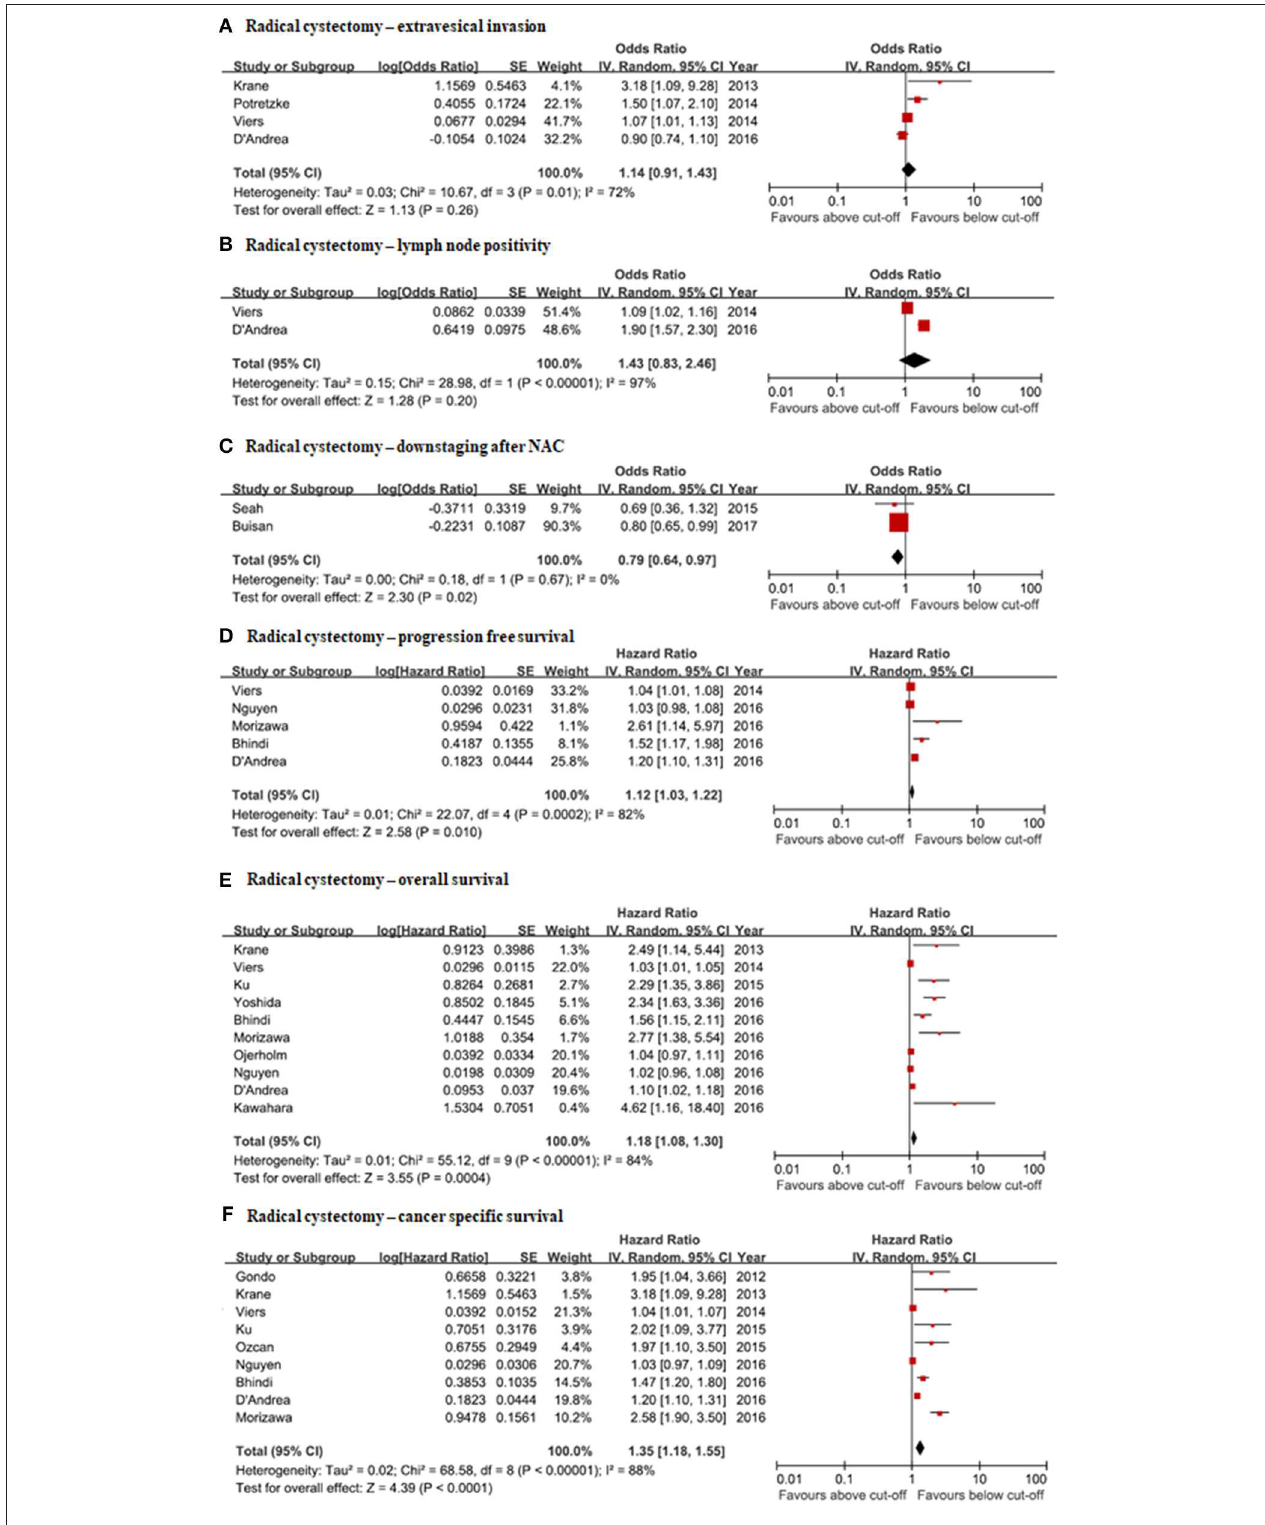
FIGURE 4 | Forrest plots of the relationship between NLRs and clinical information of radical cystectomy patients. (A) Radical cystectomy—extravesical invasion. (B) Radical cystectomy—lymph node positivity. (C) Radical cystectomy—downstaging after NAC. (D) Radical cystectomy—progression free survival. (E) Radical cystectomy—overall survival. (F) Radical cystectomy—cancer specific survival.